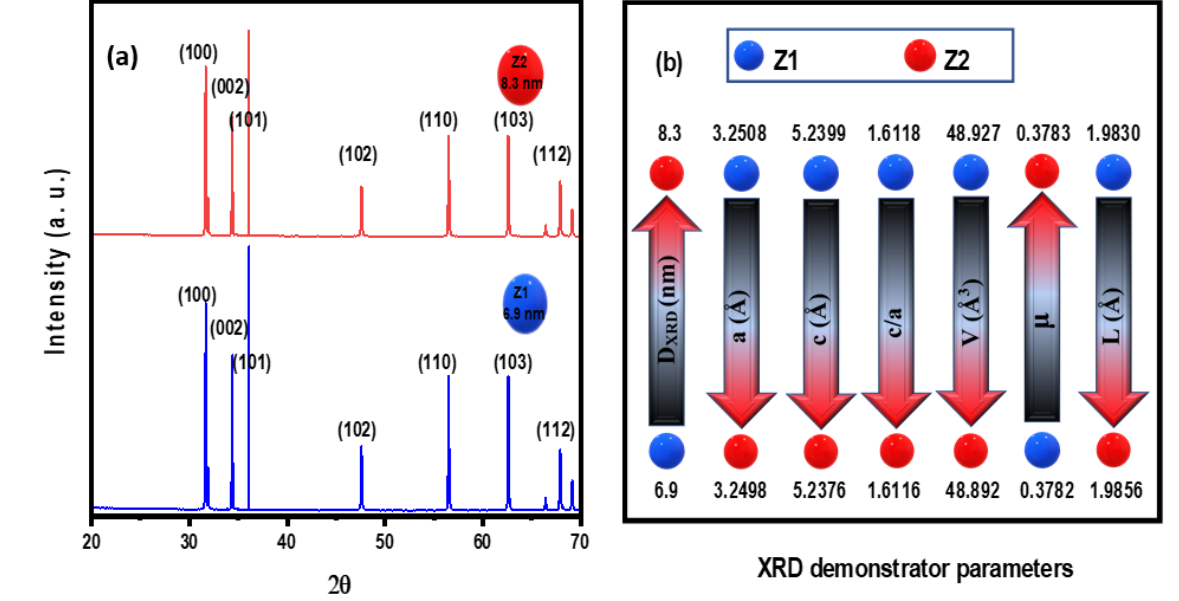
Figure 1. XRD pattern of ZQDs ( a ), XRD demonstrator parameters ( b ).